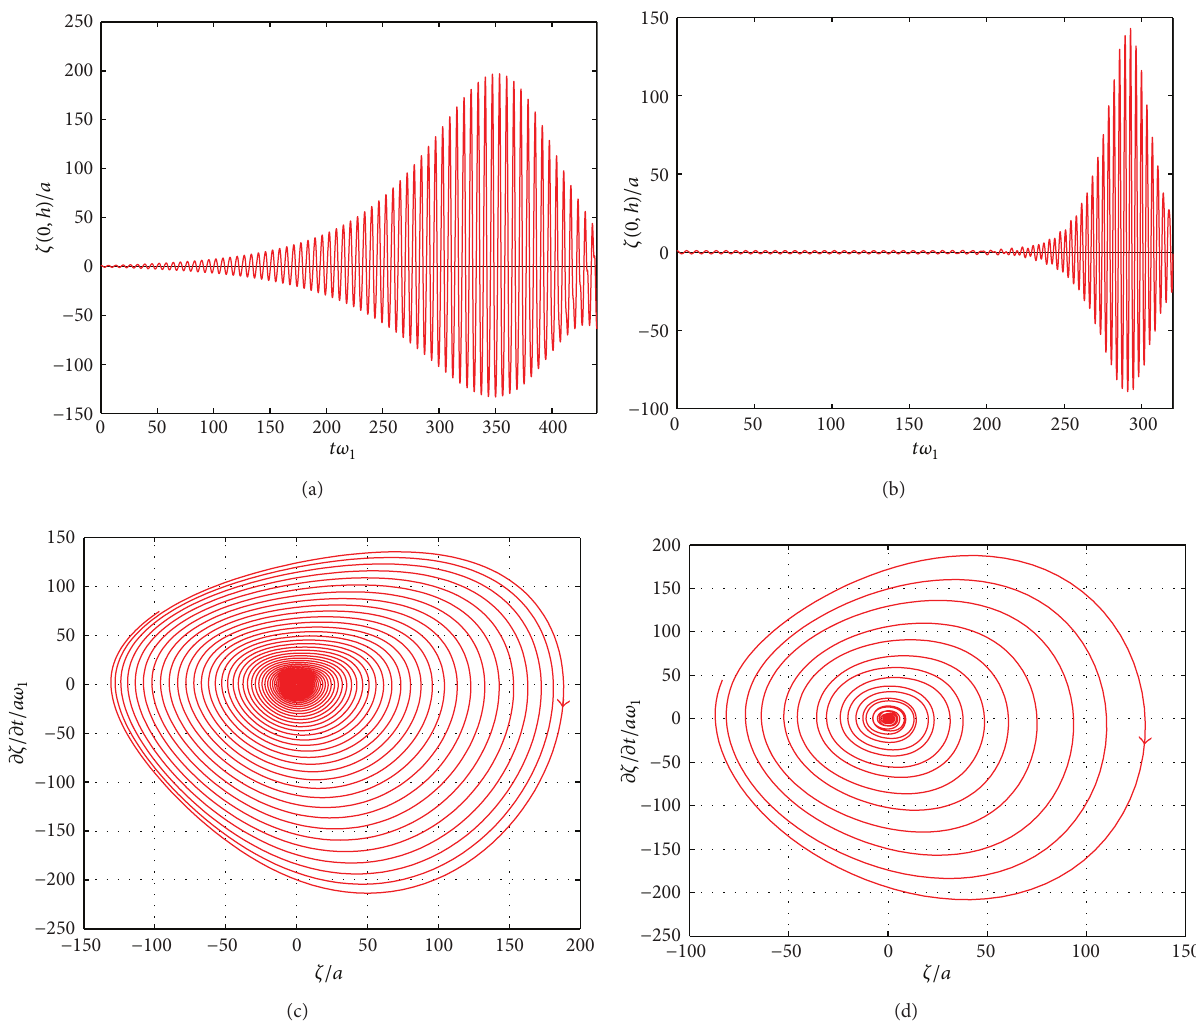
Figure 8: Free-surface elevation on the left wall in the unstable regions with 𝜀 = 0.0014 : for (a) Ω 1 = 1.0 , 𝑘 V = 0.5 (test case 3) (b) Ω 3 = 0.5 , = 0.4 (test case 4), and the respective phase-plane 𝑘 V